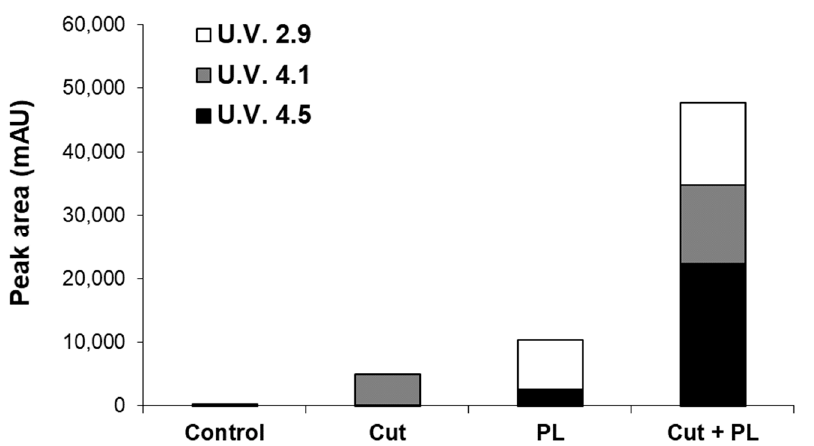
Figure 8. Major peaks evident by ELSD-RP HPLC analysis of a chloroform extract of the residual reaction fluid after incubation with cutinase (Cut) and pectin lyase (PL), separately or in combination. The reaction conditions are detailed in Figure 7B. Decomposition products are specific for each enzyme: pectin lyase—peaks at 2.9 and 4.5 min and cutinase—peaks at 4.1 min.